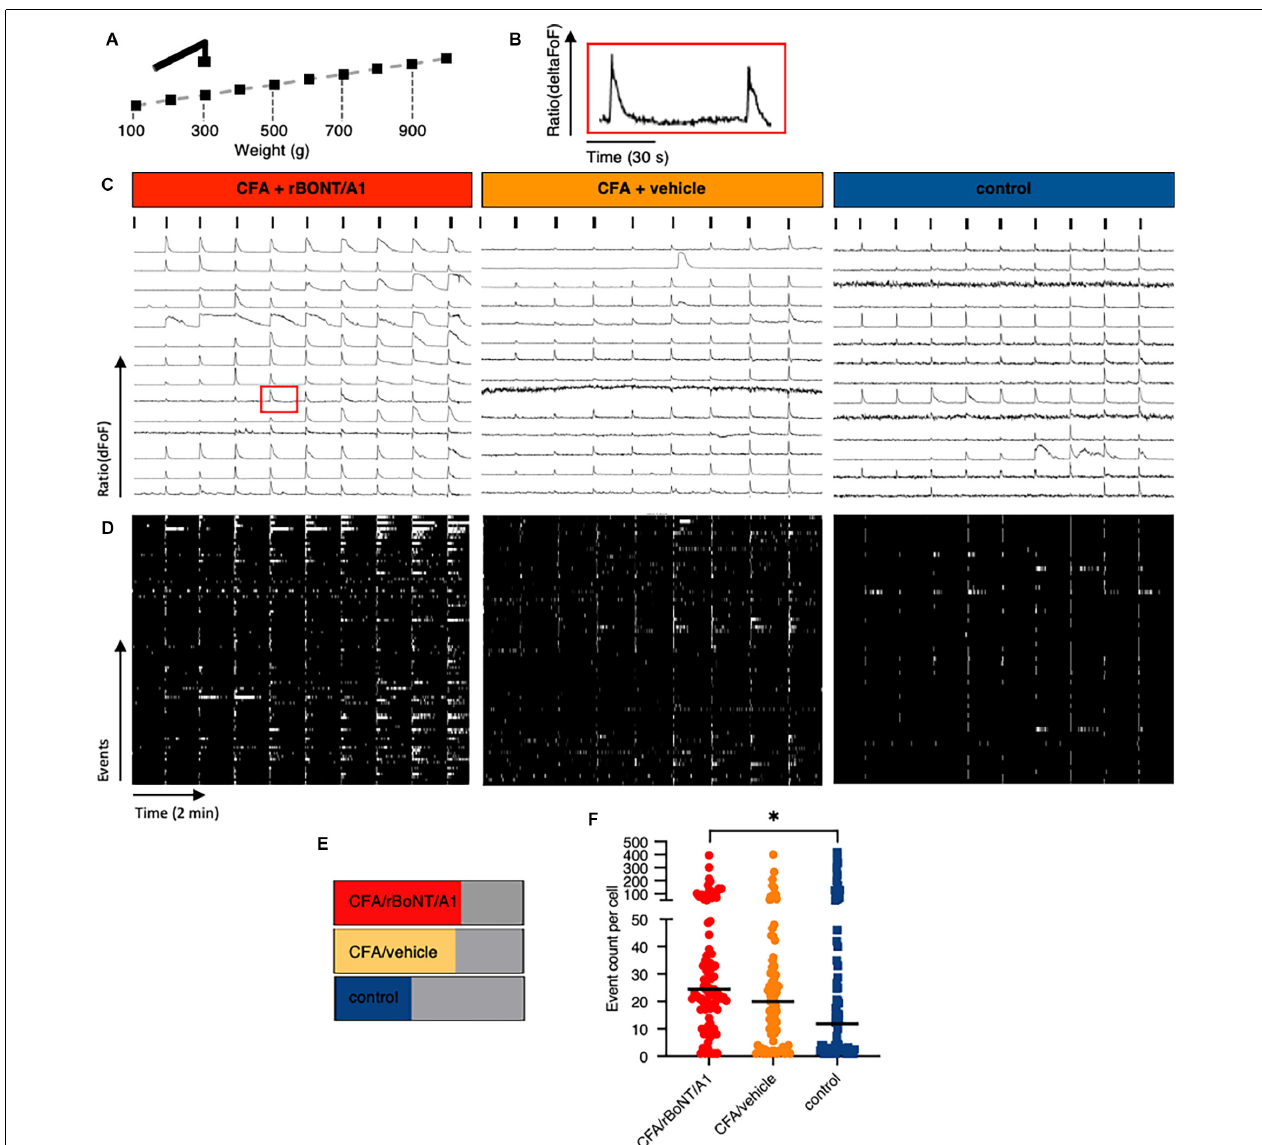
FIGURE 6 | Prolonged discharge of DRG neurons after mechanical stimulation in mice with local CFA-provoked inflammation uncovered by in vivo calcium imaging. (A) Schematic drawing of the mechanical stimulation protocol corresponding to the traces shown below. (B) Enlarged trace of a calcium transient taken from (C) (CFA/rBoNT/A1, 500–600 g, 9th cell, red square). (C) Example traces of fluorescence changes upon mechanical stimulation over time in any DRG neuron of three different mice treated as indicated. Ticks indicate mechanical event as shown in (A) . (D) Raster plots of deconvoluted data of calcium events corresponding to individual calcium traces shown in (C) . (E) Percentage of cells responding to mechanical stimuli under different treatment conditions as indicated. (F) Plot of summed deconvoluted events per cell and median taken from animals with indicated treatments. n (CFA/rBoNT/A1) = 189; n (CFA/vehicle) = 175; n (control) = 187 neurons of n = 3 mice per group. Kruskal-Wallis ANOVA, post hoc Dunn. ∗ p < 0.05.